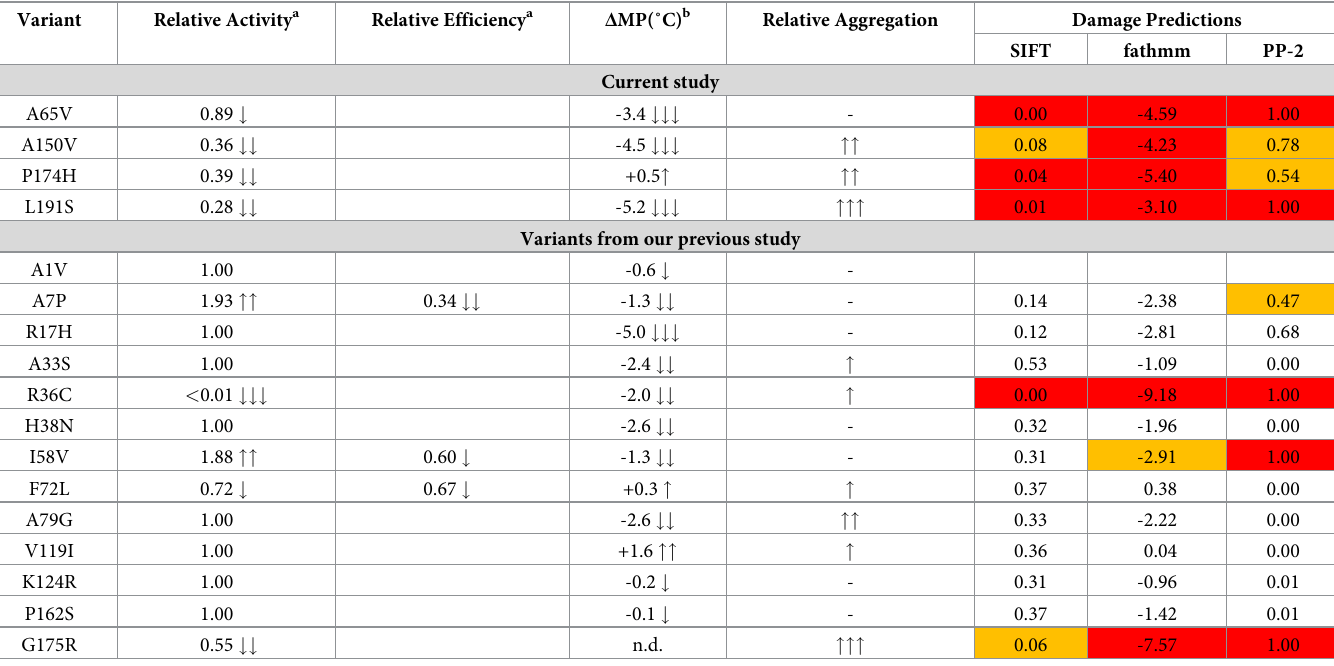
Colors indicate probability that the mutation is damaging: red (high), tan (moderate), clear (low), as predicted by the indicated algorithm. Arrows provide a qualitative indication of change relative to wild type. a Enzyme Activity (standard assay) and Efficiency (Vm/Km) are relative to WT = 1.00. b MP: change in Melting Point by